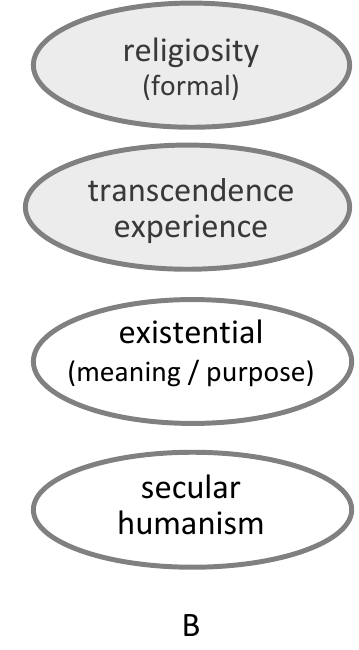
Figure 2. Overlapping constructs of spirituality, religiosity, and secular aspects. Depend- ing on the respective model, religiosity can be conceptualized as an integral aspect of a broader concept of spirituality, which may also share aspects with secular features